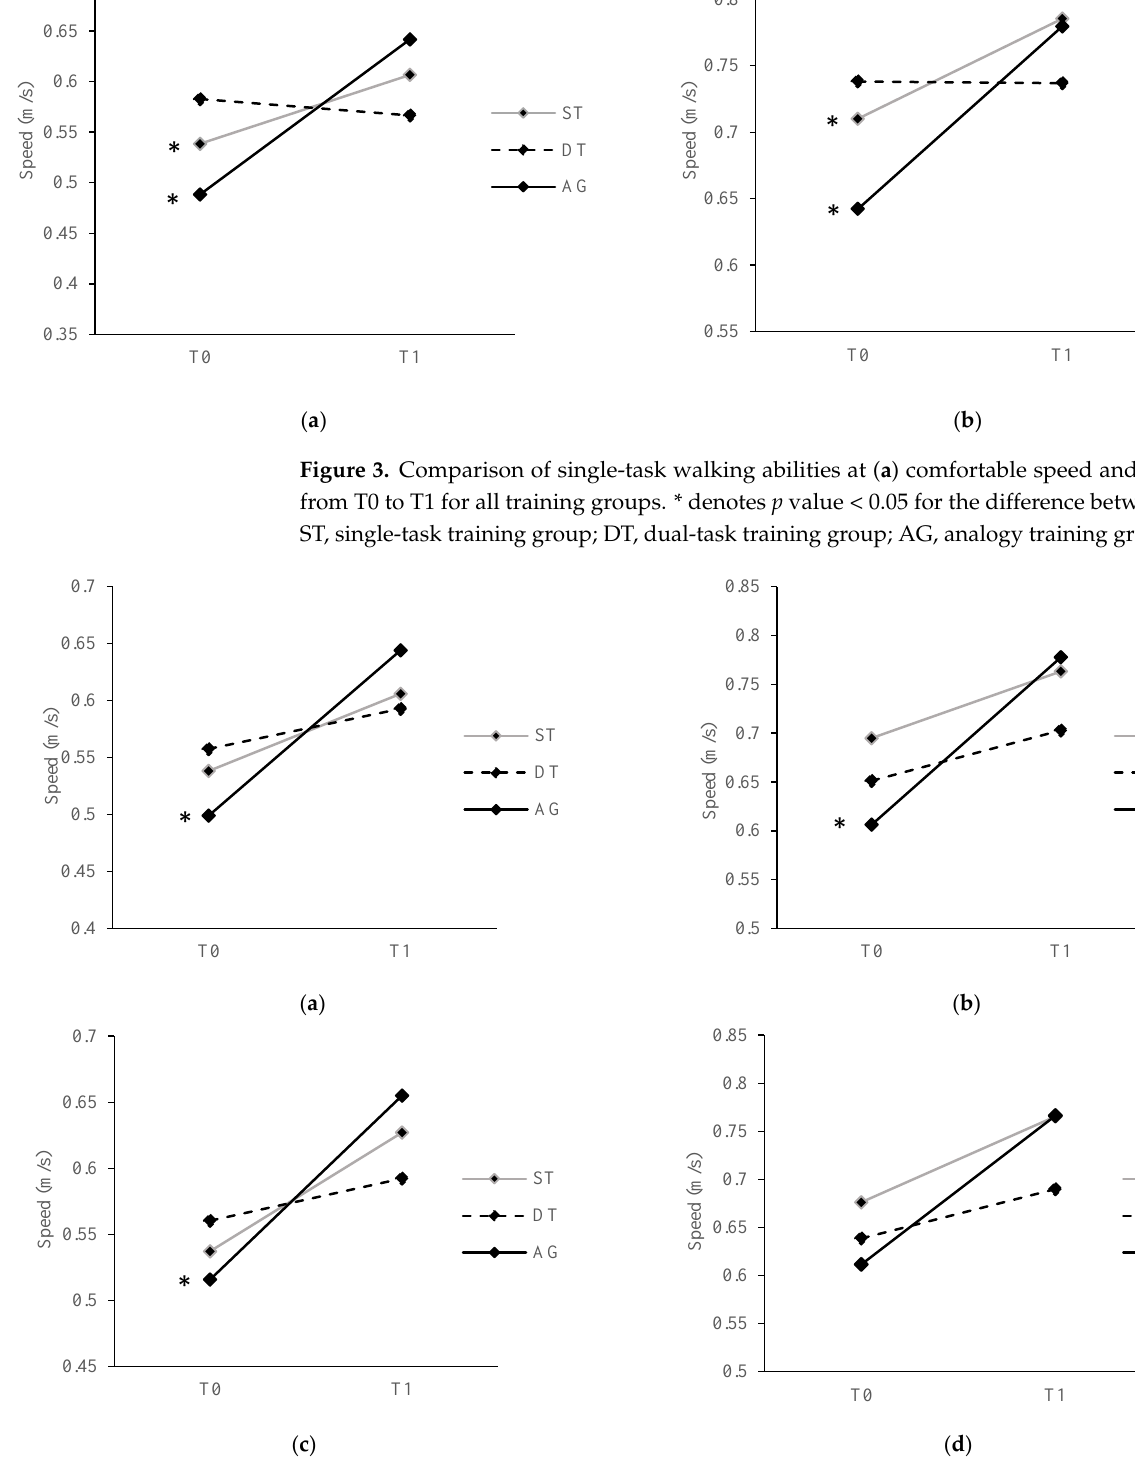
Figure 4. Comparison of dual-task walking abilities at ( a ) a verbal task at a comfortable speed; ( b ) a verbal task at a fast speed; ( c ) a visual-spatial task at a comfortable speed; and ( d ) a visual-spatial task at a fast speed from T0 to T1 for all training groups. * denotes p value < 0.05 for the difference between T0 and T1. ST, single-task training group; DT, dual-task training group; AG, analogy training group.